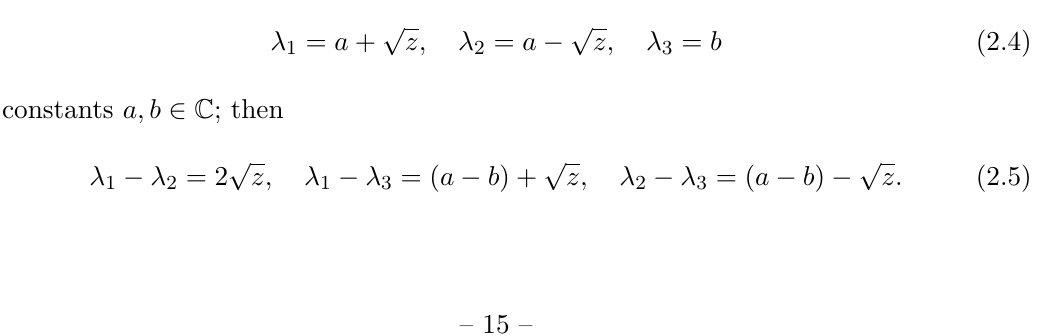
branch point, looking just like the foliation around a branch point in the N = 2 case.